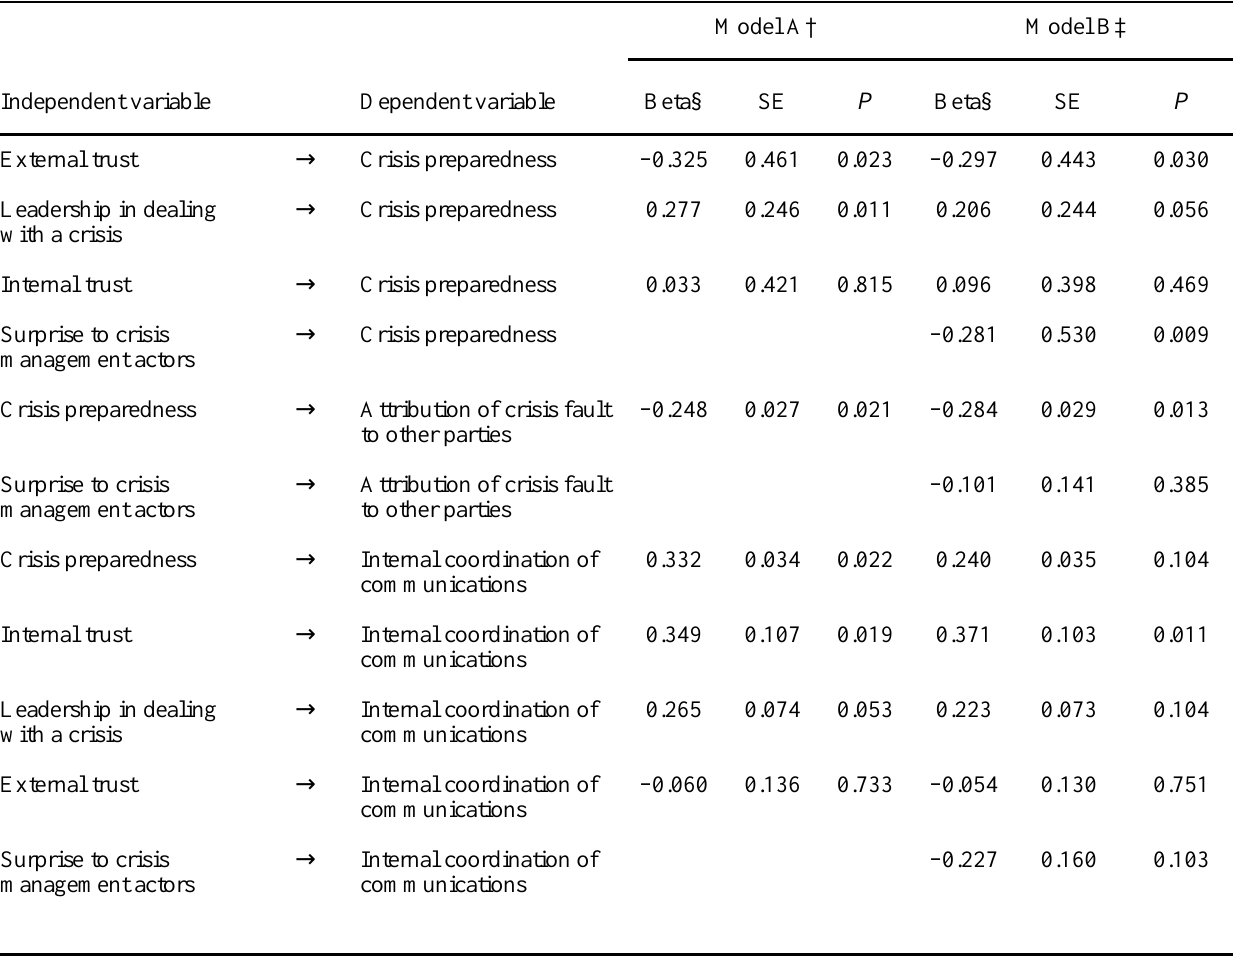
Table 5. The results of the direct effects of leadership in crisis management: standardized path